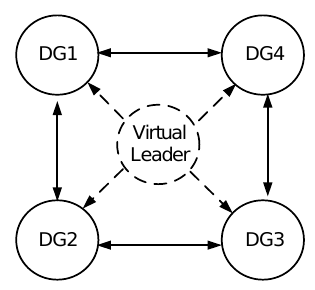
Figure 3. Distributed communication network.